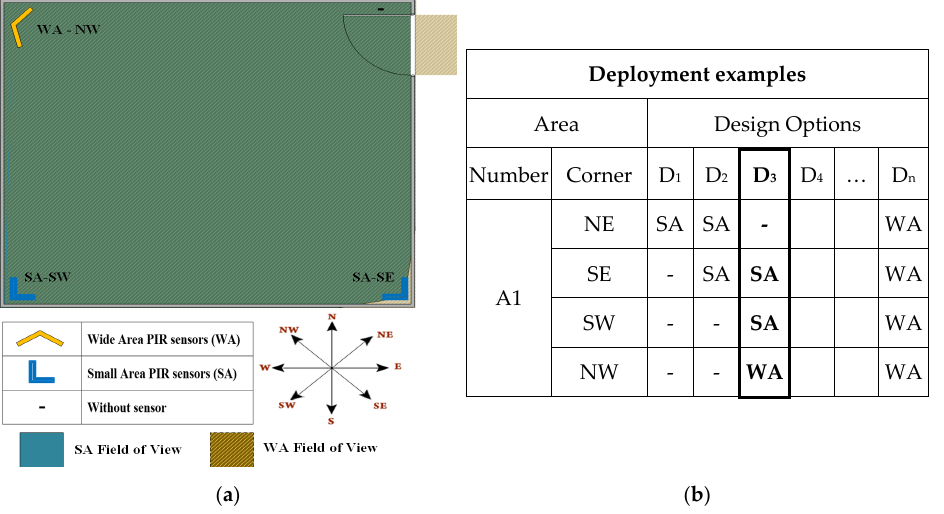
Figure 3. Proposed solution process using process mining using confusion matrix of transitions in order to change sensors’ position or angle.